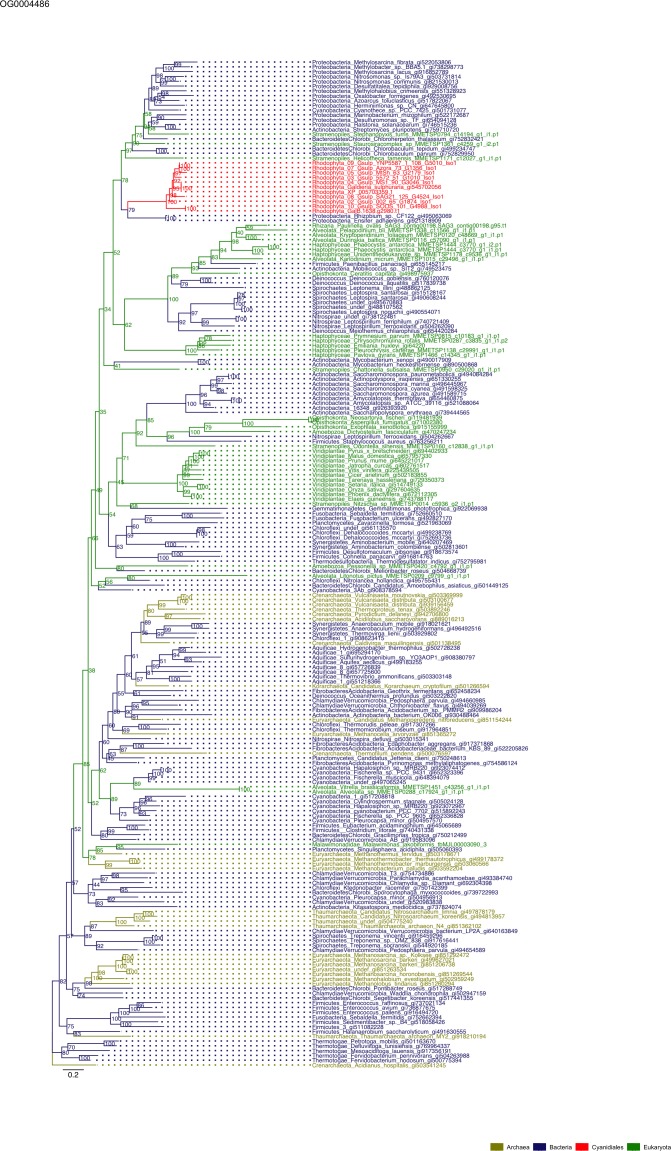
Sequence tree of orthogroup OG0004486.The tree is based on amino acid sequences. Archaea (yellow), Bacteria (blue), Cyanidiales (red), Eukaryotes including other red algae (green). Branches containing Cyanidiales sequences are highlited in red.